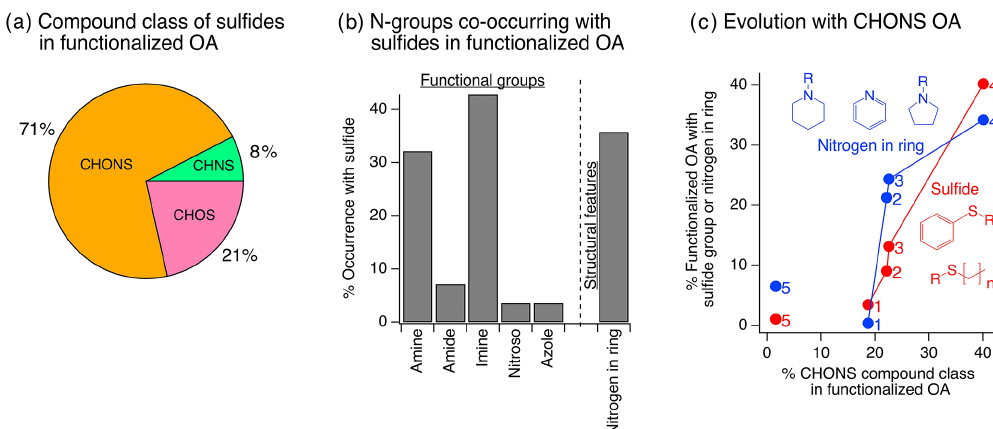
Figure 3. (a) Compound class distribution of sulfide groups: 71% of sulfide functional groups observed (weighted by ion abundance) were present in CHONS compounds. (b) Co-occurrence of sulfides and nitrogen-containing groups. Data shown in (a–b) are cumulative across compounds in screens 1–4. (c) The relative contribution of sulfides and cyclic nitrogen groups to all functionalized OA increased together with the increasing contribution of CHONS compounds. The other functional groups in (b) showed no relationship with the increase in CHONS (Fig. S7b). Structures represent examples of commonly observed sulfide and cyclic nitrogen substructures from SIRIUS and CSI:FingerID (Sect. S3), where ring structures associated with nitrogen heteroatoms were free standing, adjacent to other rings, and/or contained additional attached functional